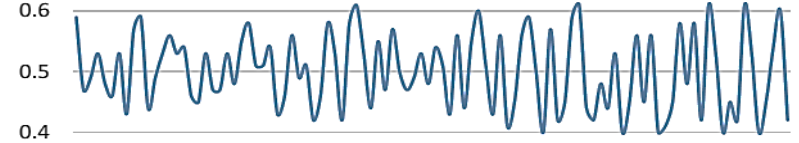
Figure 6. Percentage of 0′s and 1′s before encryption and after encryption.